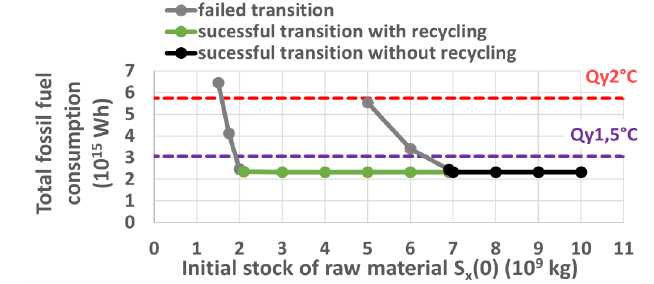
Fig. 8. Total fossil fuel consumption for runs with varying initial stock S x (0) , without recycling (black dots) and with recycling (green dots) and with t f = 100 years. Highlighting the reduc- tion of raw material requirement to achieve successful energy transition enabled by